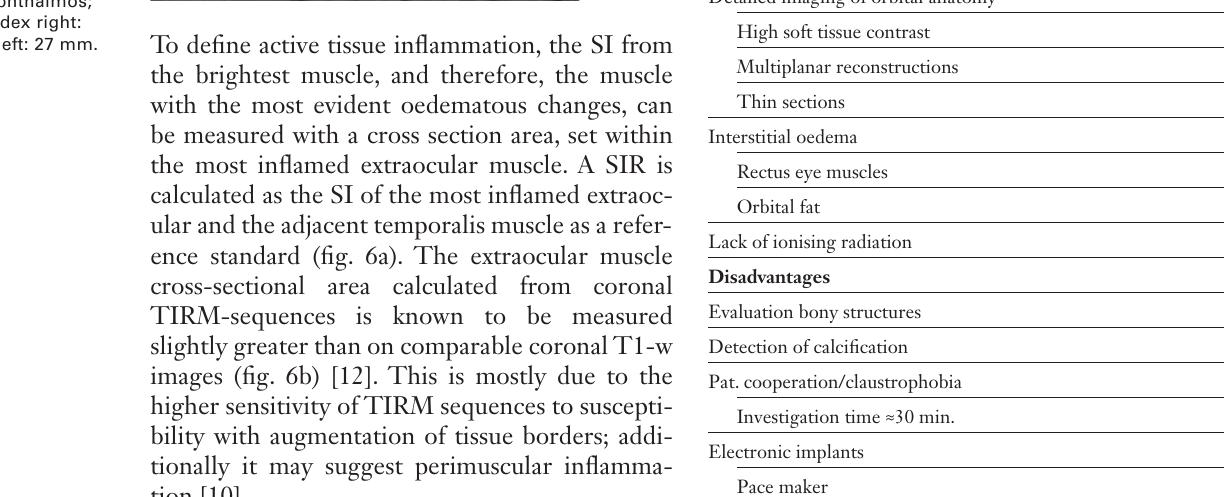
Advantages and disadvantages of MR-imaging in Graves’ or- bitopathy.